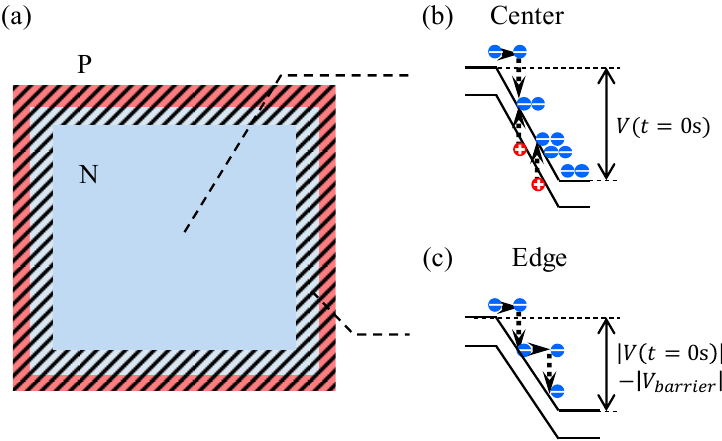
Figure 8. ( a ) A top view of a SPAD. The edge of the SPAD is hatched. ( b , c ) Simplified band diagrams at the center of the SPAD ( b ) and at the edge of the SPAD ( c ).